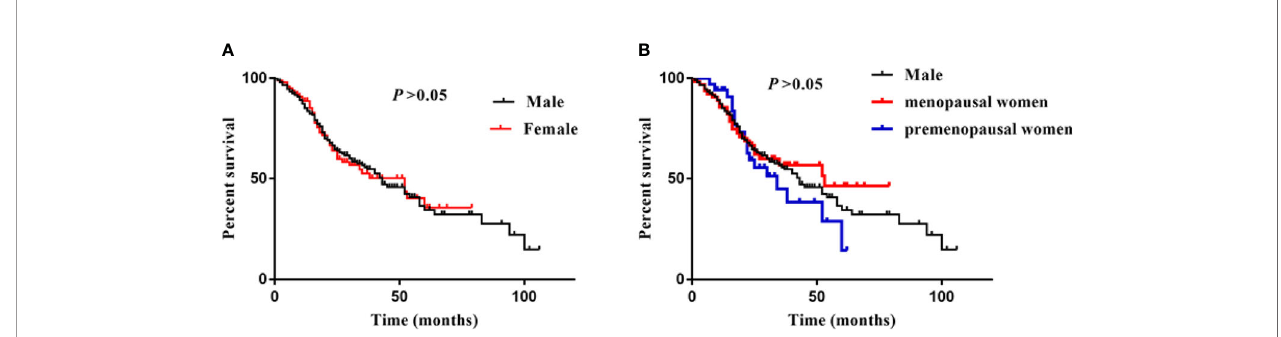
FIGURE 2 | Sex difference and ESKD. (A) was showed survival curves of male and female, (B) was showed survival curves of male, menopausal/premenopausal women. Log-rank analysis was used to compared the percent survival between male and female. There was no signi fi cant difference between male, premenopusal and menopausal female.